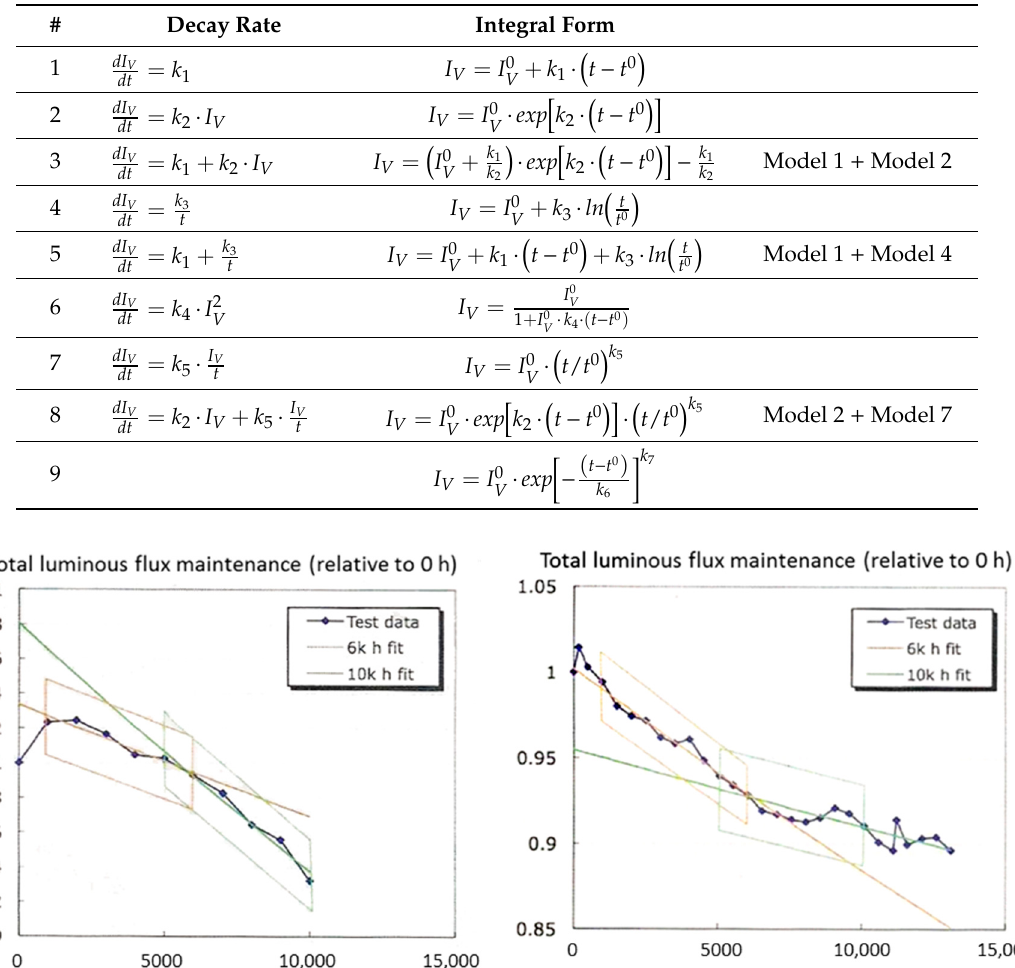
Table 1. Aging models of di ff erent decay rates with the closed form solution, i.e., the integral form (after [49]).